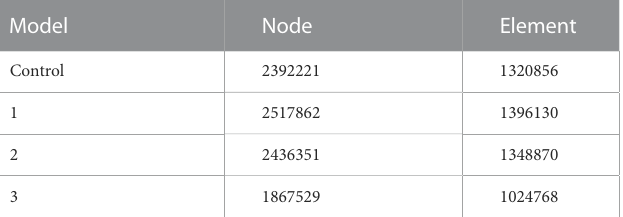
TABLE 1 The number of elements and nodes for the models.